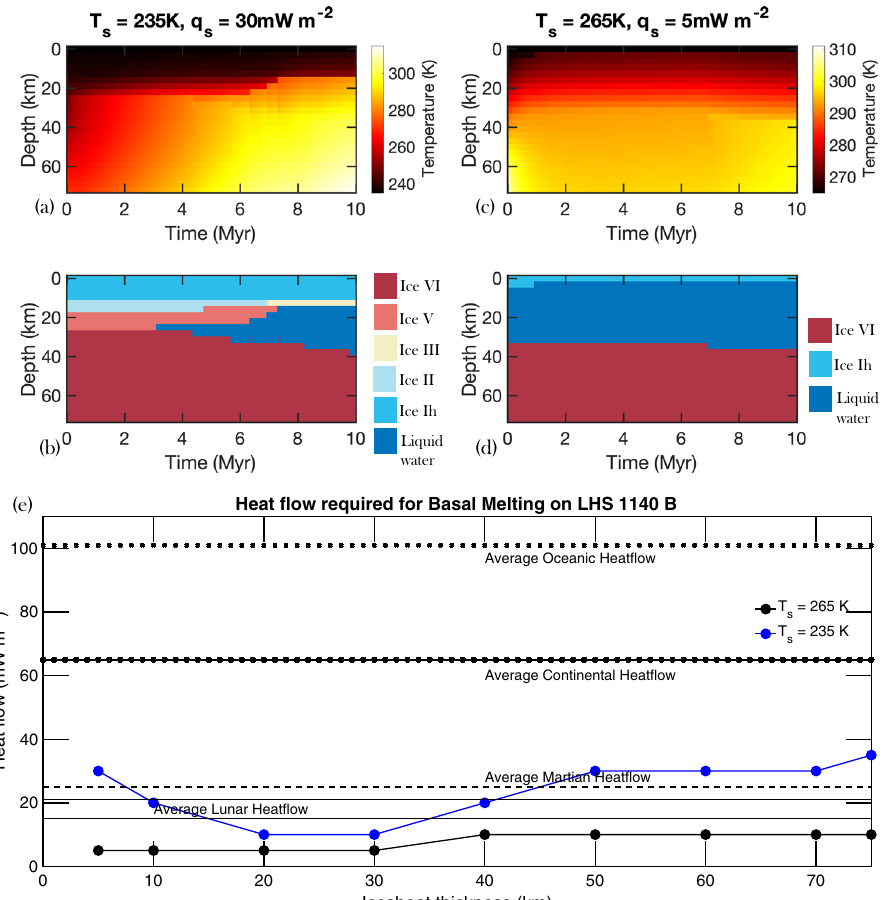
Fig.7|Heat fl owrequiredforbasalmeltingonsuper-Earthsasafunctionofthe icesheetthickness.a Temperaturedistributionasafunctionofdepthandtimeon LHS1140bfora70kmthickicesheet, T s of235K,andheat fl owof30mWm − 2 . b Ice phase evolution as a function of depth and time on LHS 1140 b over a 10-million- year time period. The melt water underneath the high-pressure ice phases quickly migratestoshallowerdepths;however,themigrationofbuoyantliquidwaterisnot modeled here. c Temperature distribution as a function of depth and time on LHS 1140bfora70kmthickicesheet, T s of265K,andheat fl owof5mWm − 2 . d Icephase evolutionasafunctionofdepthandtimeonLHS1140bovera10-million-yeartime